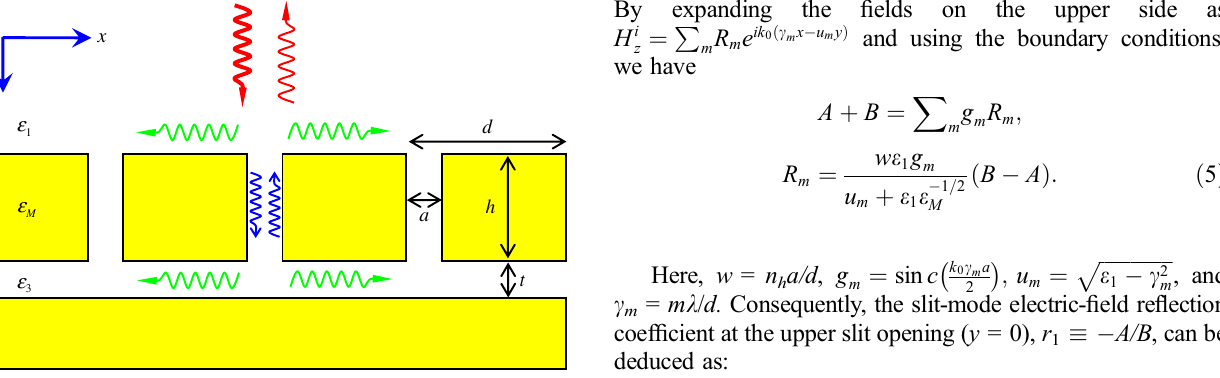
Figure 2. Schematic view and physical parameters of the plasmonic system under study. The slit grating (with a narrow slit width) and ground plane are separated by a thin dielectric spacer. The vertical narrow slits support a deep subwavelength FP-like resonance. Such resonance can be excited by a TM-polarized incident